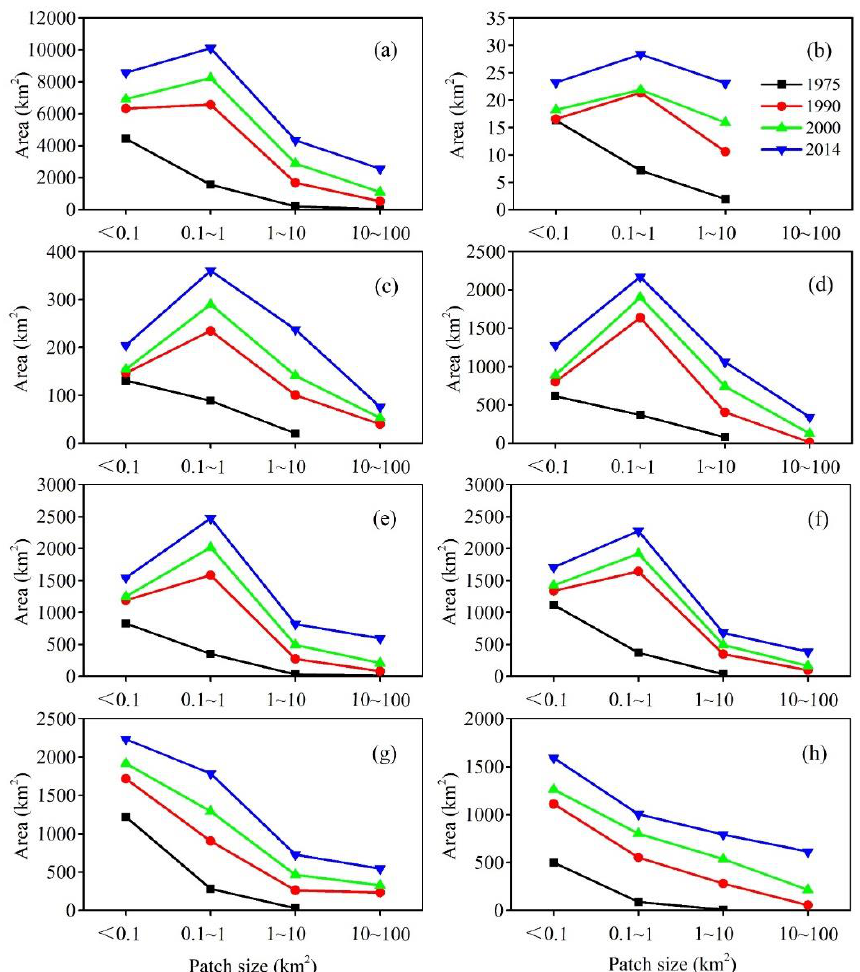
Figure 12. Area distributions of the built-up land in floodplains with di ff erent patch sizes in the North China Plain Area: ( a ) North China Plain Area; ( b ) Beijing; ( c ) Tianjin; ( d ) Hebei; ( e ) Shandong; ( f ) Henan; ( g ) Anhui; and ( h ) Jiangsu.